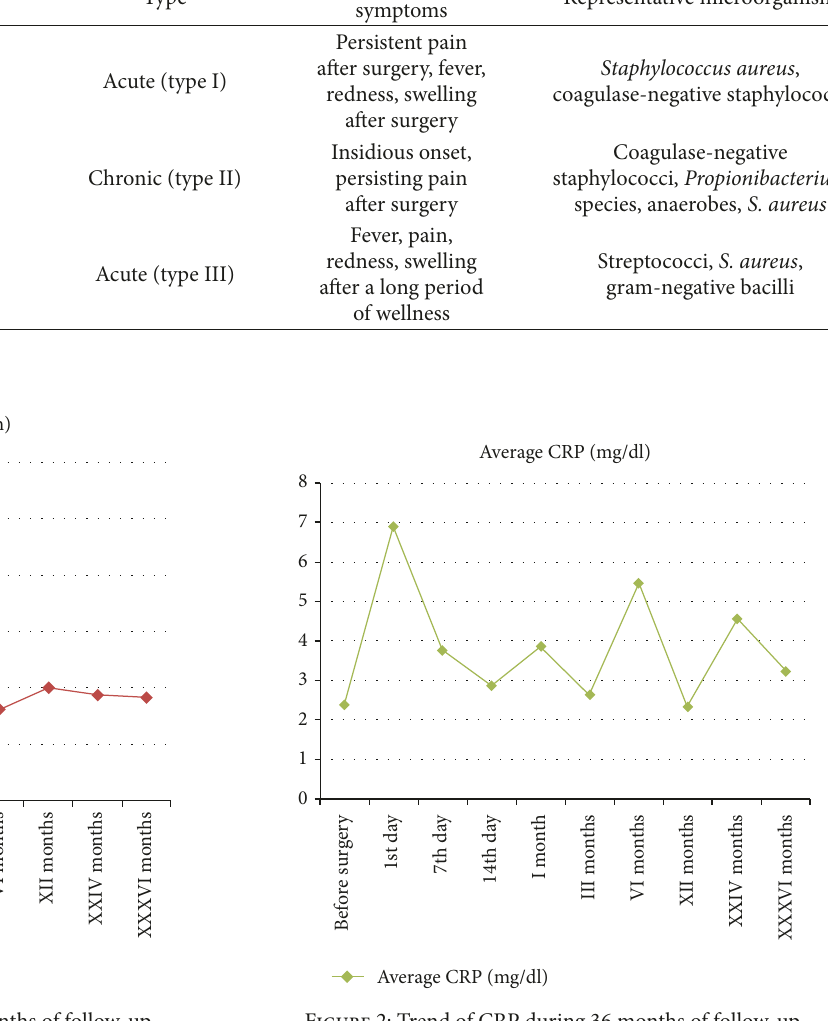
Figure 1: Trend of ESR during 36 months of follow-up. Figure 2: Trend of CRP during 36 months of